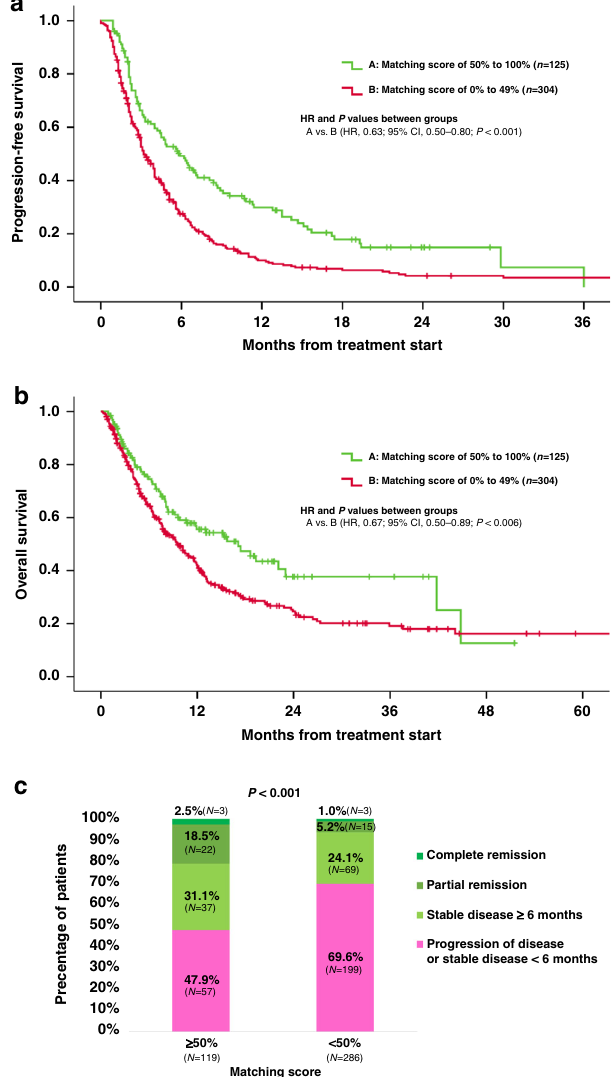
Fig. 3 Progression-free survival, overall survival and clinical bene fi t rate (SD ≥ 6 months/PR/CR) according to the high ( ≥ 50%) vs. low (<50%) matching scores. a Progression-free survival according to the high ( ≥ 50%) vs. low (<50%) matching scores ( N = 429). Progression-free survival was signi fi cantly longer among patients who received therapy with high ( ≥ 50%) matching score when compared to patients treated with low (<50%) matching scores. b Overall survival according to the high ( ≥ 50%) vs. low (<50%) matching scores ( N = 429). Overall survival was signi fi cantly longer among patients who received therapy with high ( ≥ 50%) Matching Score when compared to patients treated with low (<50%) Matching Scores. c Clinical bene fi t rate (SD ≥ 6 months/PR/CR) according to the high ( ≥ 50%) vs. low (<50%) matching scores ( N = 405*). Clinical bene fi t rate (SD ≥ 6 months/PR/CR) was signi fi cantly higher among patients who received therapy with high ( ≥ 50%) Matching Score when compared to patients treated with low (<50%) Matching Scores (52.1% vs. 30.3% [ P <